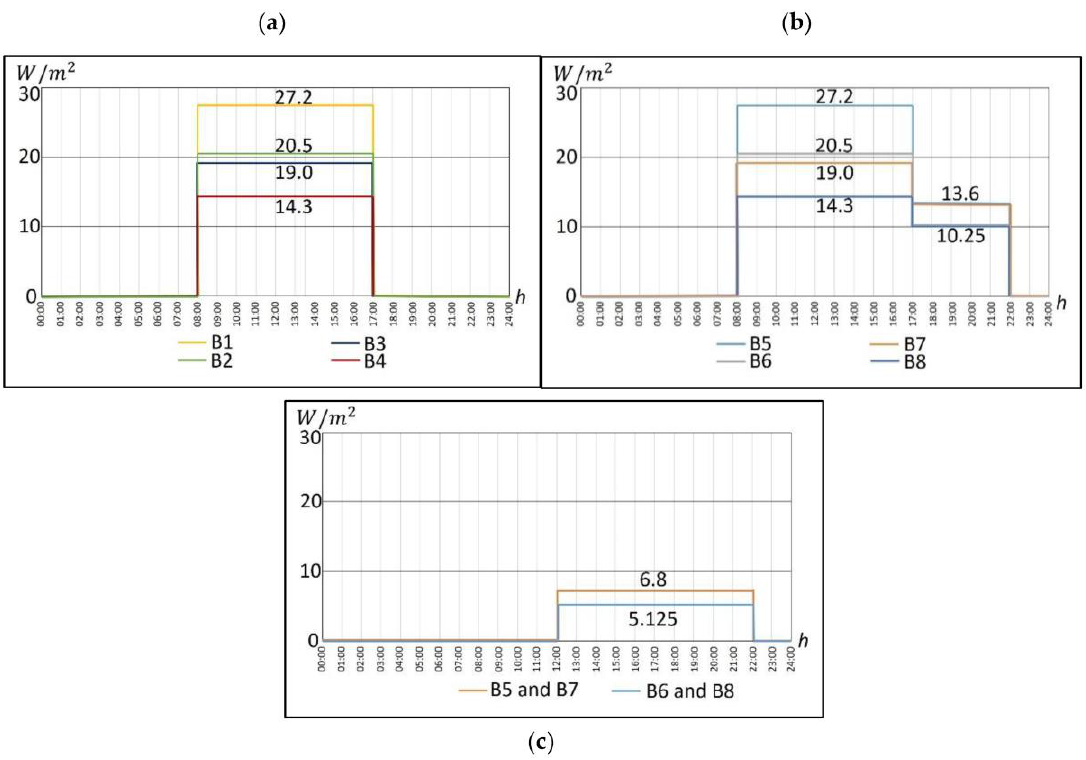
Figure 2. The total amount of internal heat gains from electricity use and occupancy combined for all the different cases of internal heat gains. ( a ) The schedule for workdays for cases B1, B2, B3 and B4, as described above, ( b ) the schedule for workdays for cases B1, B2, B3 and B4, as described above, and ( c ) the schedule for weekends, holidays and vacation period for cases B5, B6, B7 and B8. B1, B2, B3 and B4 have no internal heat gains during weekends and vacation.